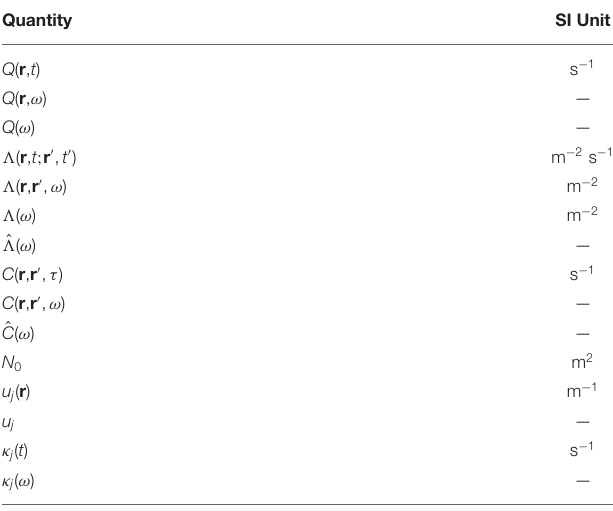
TABLE 1 | Quantities in Equations (1–14) and their SI units. Quantity SI